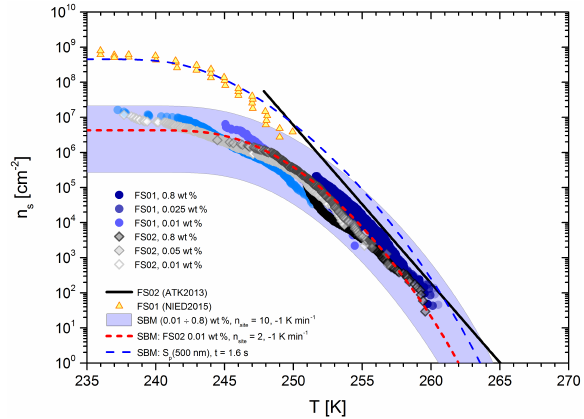
Figure 9. n s (T ) curves of K-feldspar particles FS01 and FS02. The shaded area shows the range of n s (T ) values predicted by Eq. (4) with fixed parameter set µ θ = 1 . 32 rad, σ θ = 0 . 1 rad, n site = 10, and suspension between 0.01 and 0.8wt%. The red broken line corresponds to the best-fit parameter set for FS02 (Table 2a) with 0.01wt% and d T/ d t = − 1Kmin − 1 . The blue broken line is calcu- lated with the same parameter set but assuming a single FS01 parti- cle with Stokes diameter 500 nm per droplet and fixed temperature lasting for 1.6s (LACIS conditions) instead of constant cooling